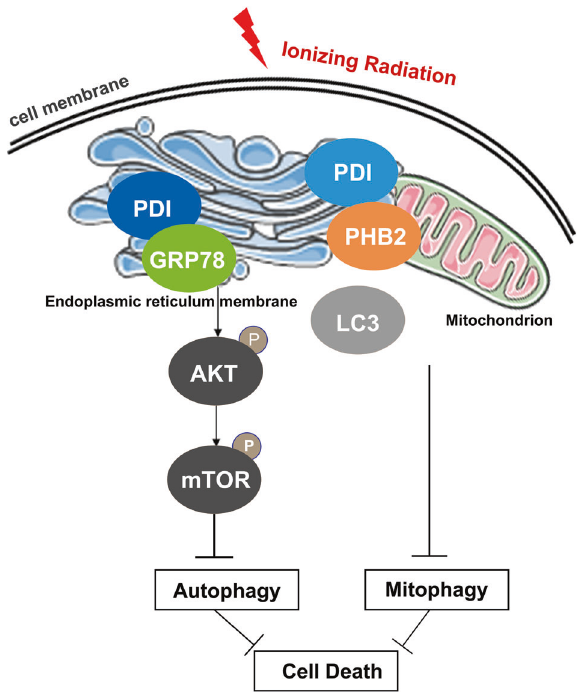
Fig. 8 Schematic diagram to show the effect of PDI regulating autophagy in CRC. Under radio/chemo-therapy conditions, PDI interacts with GRP78 to inhibit the degradation of AKT, and eventually activates the mTOR pathway and inhibits autophagy initiation. In parallel, radio/chemo-therapy mediates the transfer of PDI from the ER to mitochondria, and translocated PDI competes with LC3 to bind PHB2 on mitochondria to inhibit